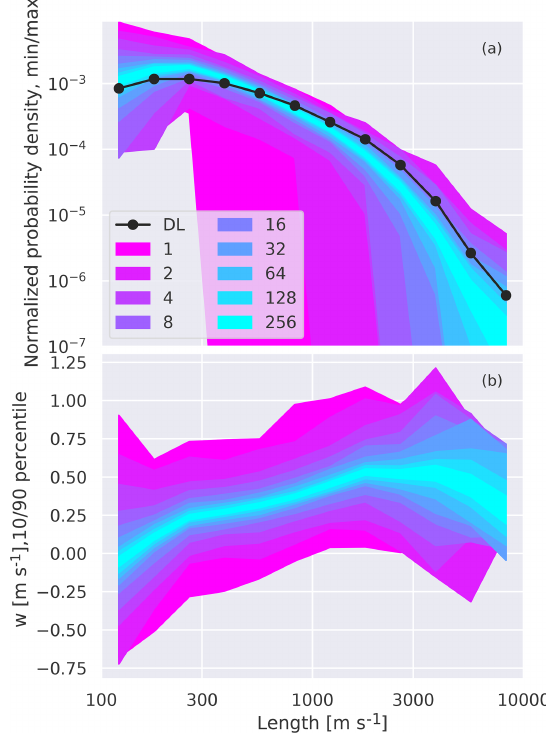
Figure 12. Chord-length distribution (a) and mean vertical velocity below the chord binned by chord length (b) as a function of chord length based on simulation data. The shading in (a) shows the min- imum or maximum value that results from randomly sampling and combining n columns 386 times (details in Sect. 7). The shading and legend mark how many n 1D column outputs were combined together in each random sample. The shading in (b) fills the 10th to 90th percentile of all the samples. The black line is the Doppler lidar data, which shows roughly the same number of chords as we detect from 250 column